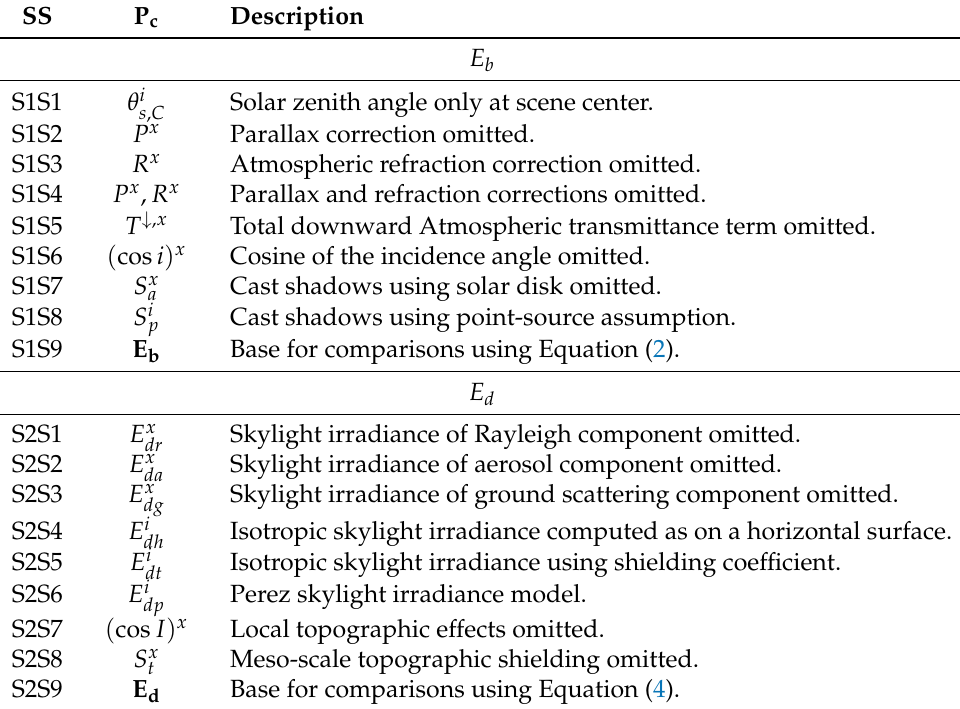
Table 3. Simulation and control scenario (SS) descriptions for generating estimates of irradiance components. Control parameters ( P c ) for a scenario were included ( i ) or excluded ( x ) for comparison to a more fully comprehensive parameterization